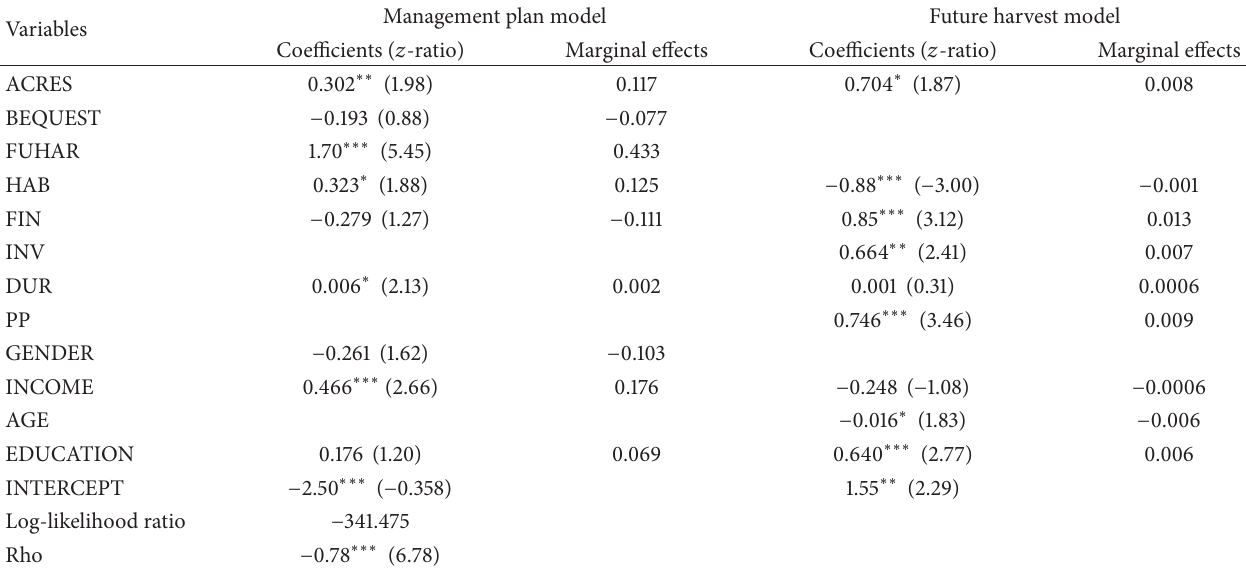
Table 2: Results of recursive bivariate probit regression on landowner decision to prepare forest management plan and to harvest timber in